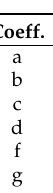
Table 2. V2I equation coefficients.